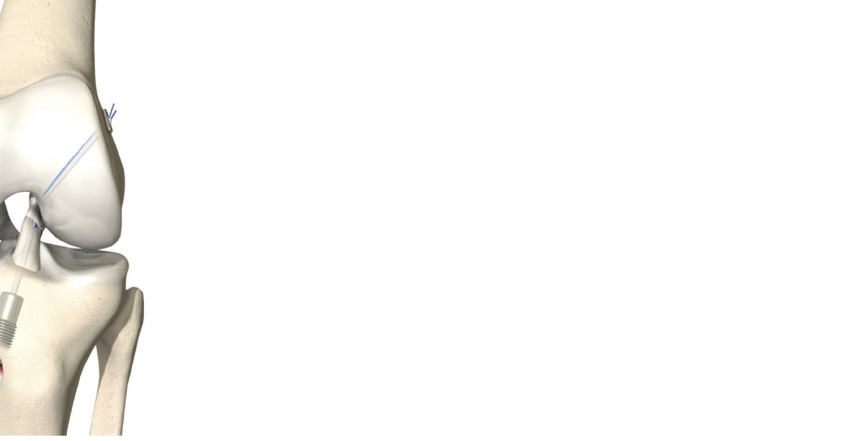
Figure 1. Dynamic intraligamentary stabilization of the left knee, frontal view. This image can be found in the “Surgical technique Ligamys” brochure, Mathys Ltd. Bettlach [3]. Permission was granted by the company, Mathys Ltd. Bettlach, to use this picture in a journal article.